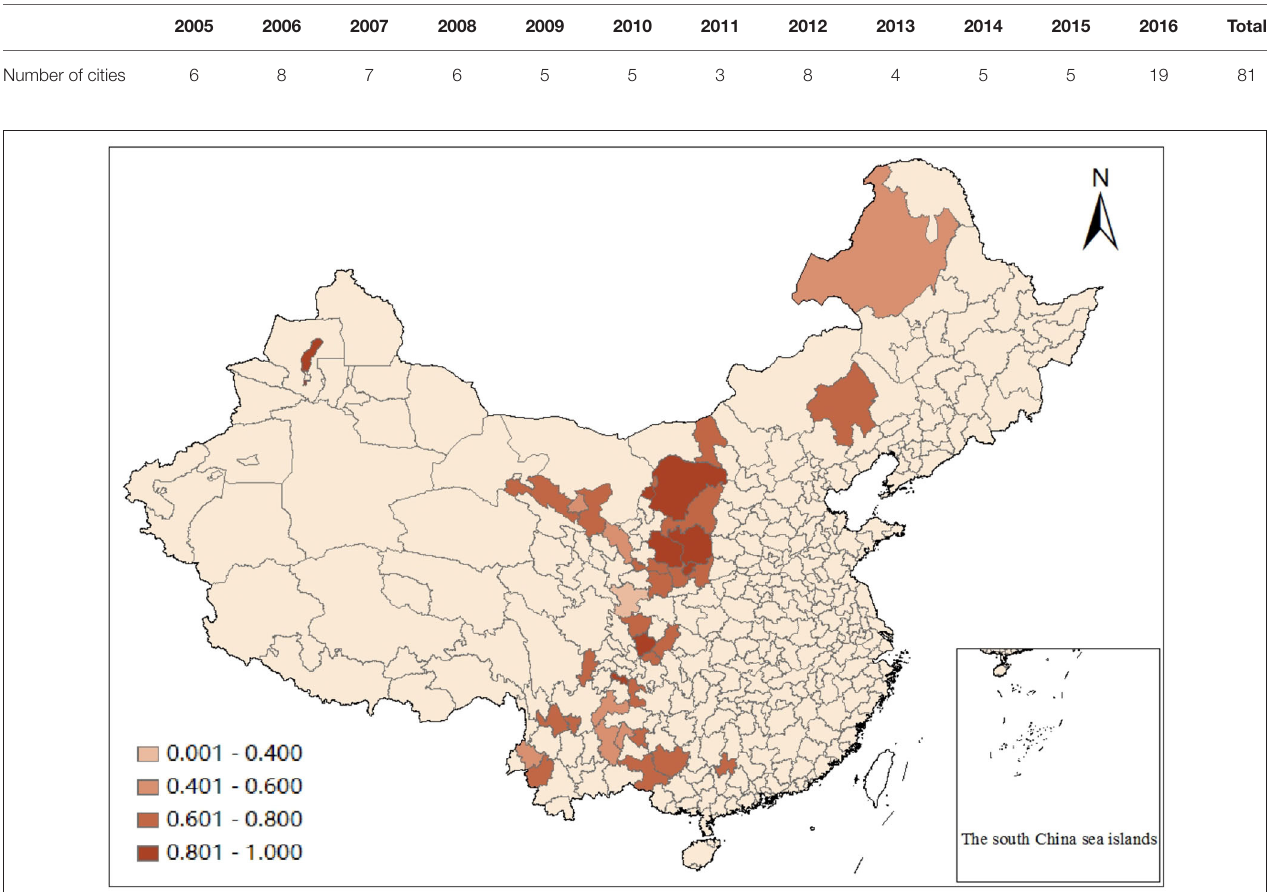
TABLE 2 | Number of cities with effective static efficiency ( ≥ 1) from 2005 to 2016.